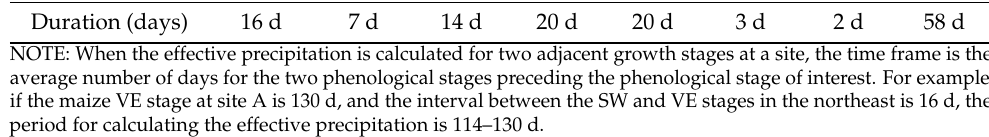
Table 1. Duration of each stage of maize in Northeast China.